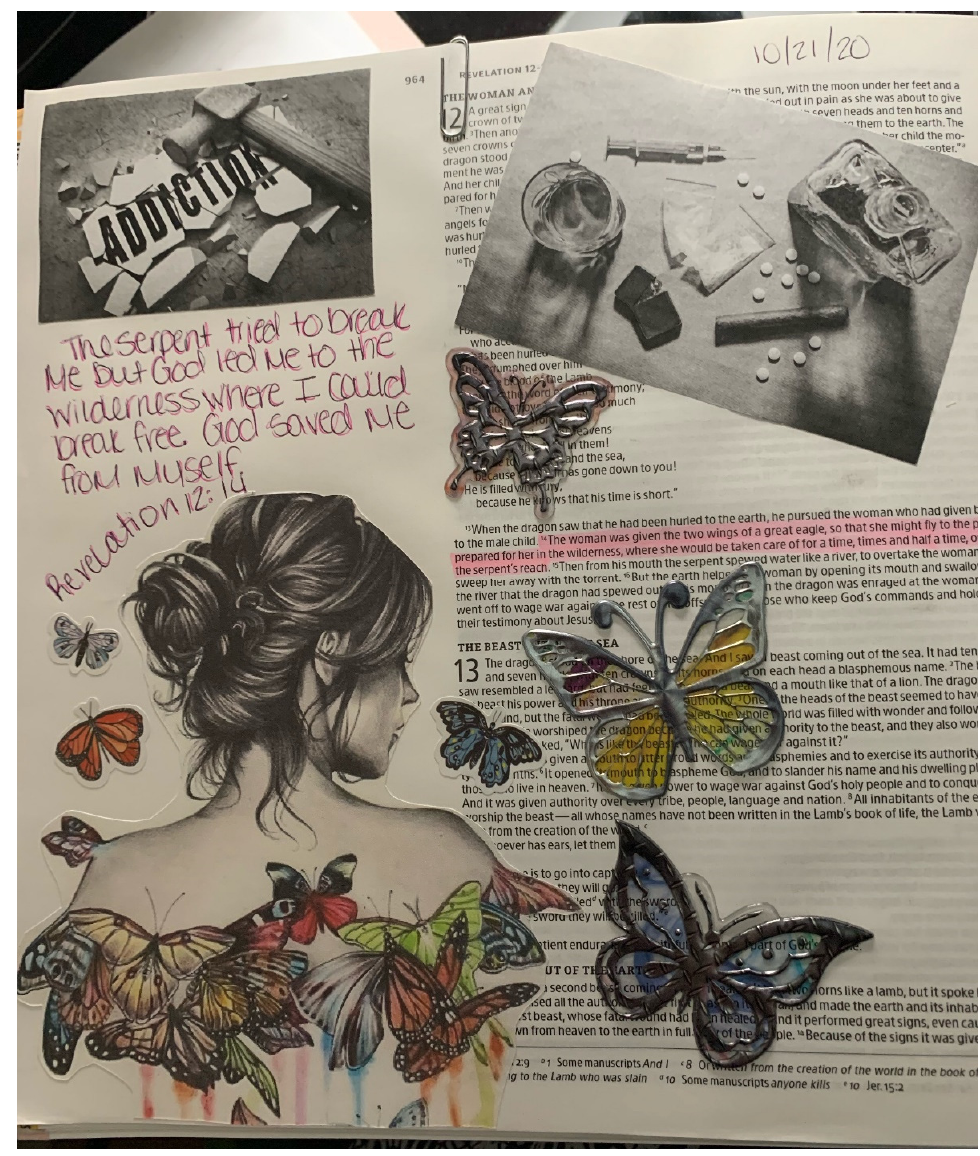
Figure 8. Revelation 12:14. With kind permission of the journaler.